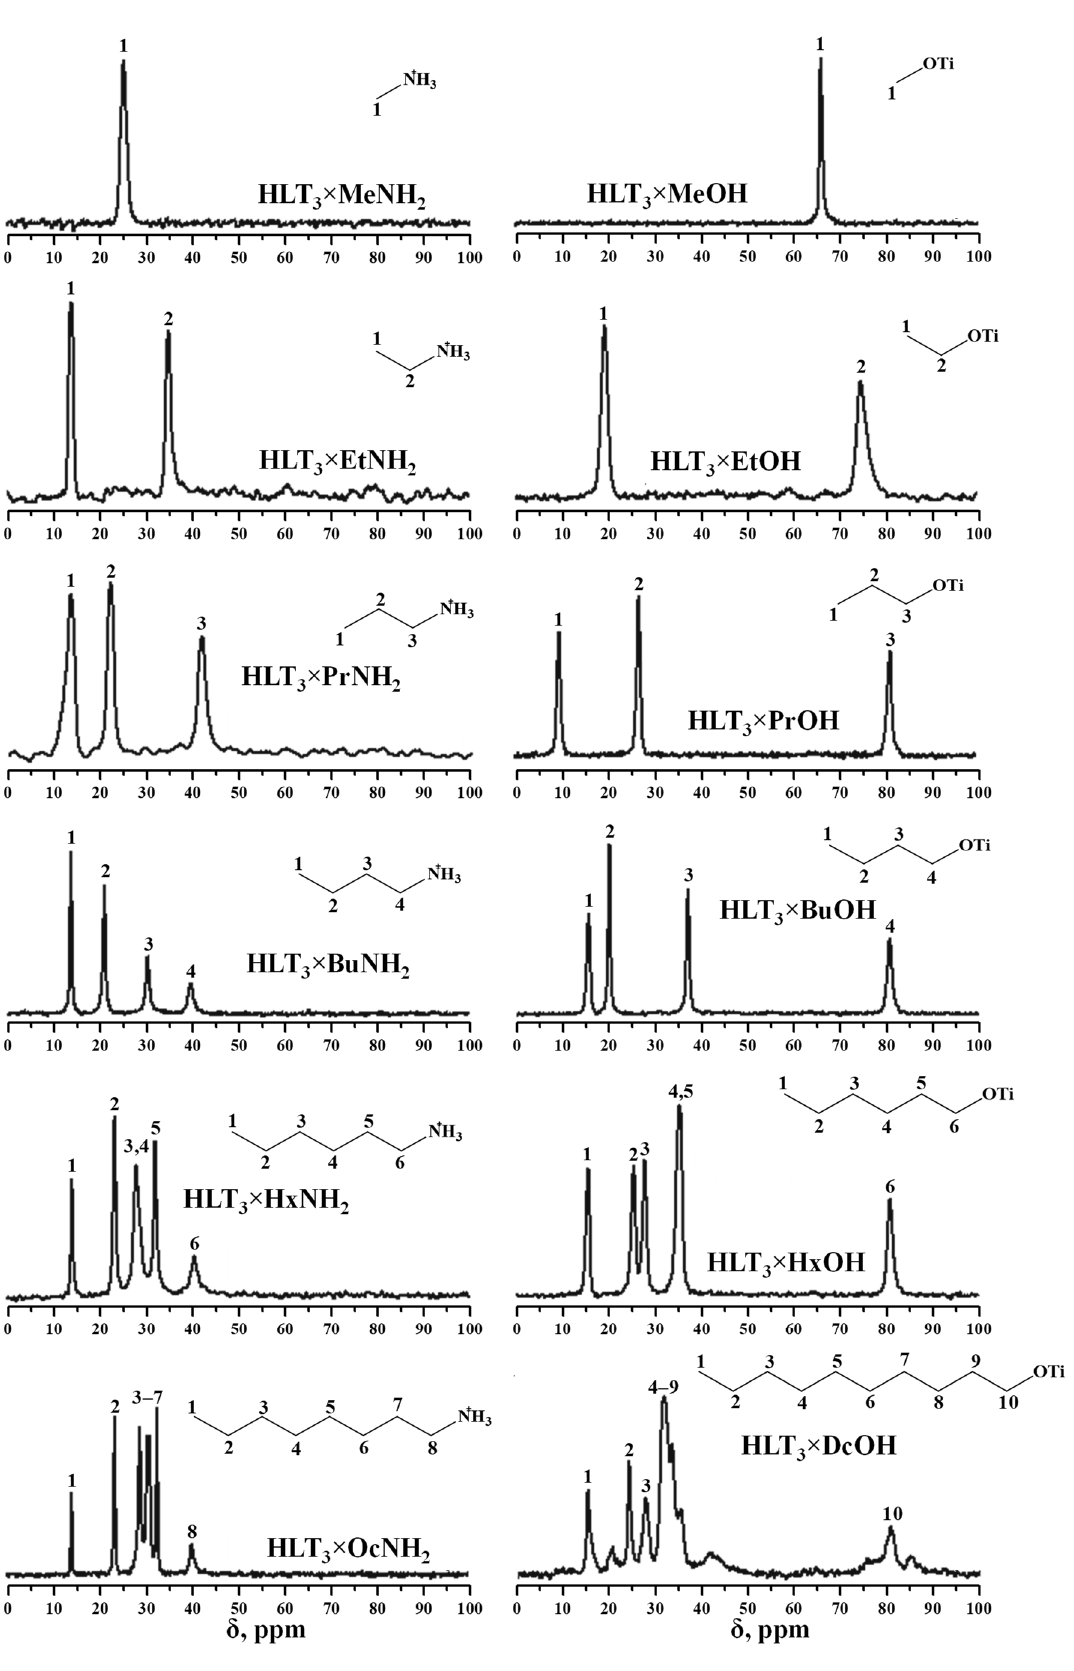
Figure 4. 13 C NMR spectra of La-containing inorganic-organic derivatives.